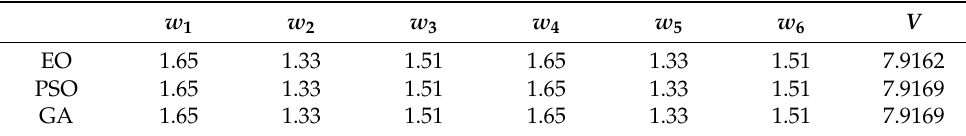
Table 9. Allocated tasks for the AUVs and the value of the goal function in the middle-scale system under w total = 36 kg. w 1 w 2 w 3 V EO GA Table 10. Allocated tasks for the AUVs and the value of the goal function in the large-scale system under w total = 36 kg. w 1 w 2 EO